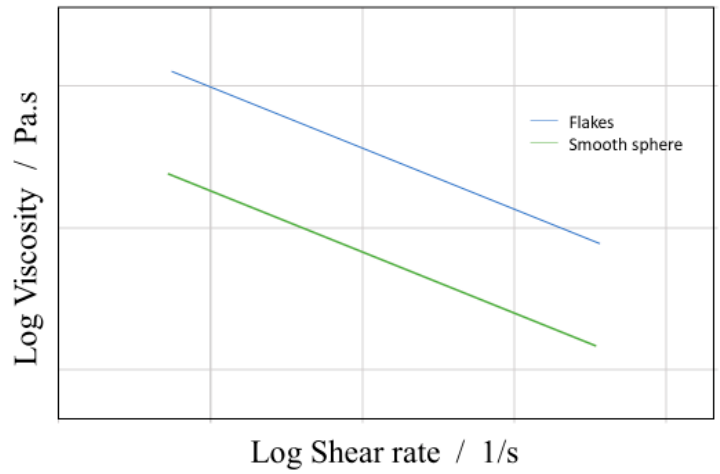
Figure 4. General relationship of viscosity and shear rate, for flake suspension versus smooth sphere suspension ( Sketch representation of the general trend concluded from Ran Niu et al. [19]).